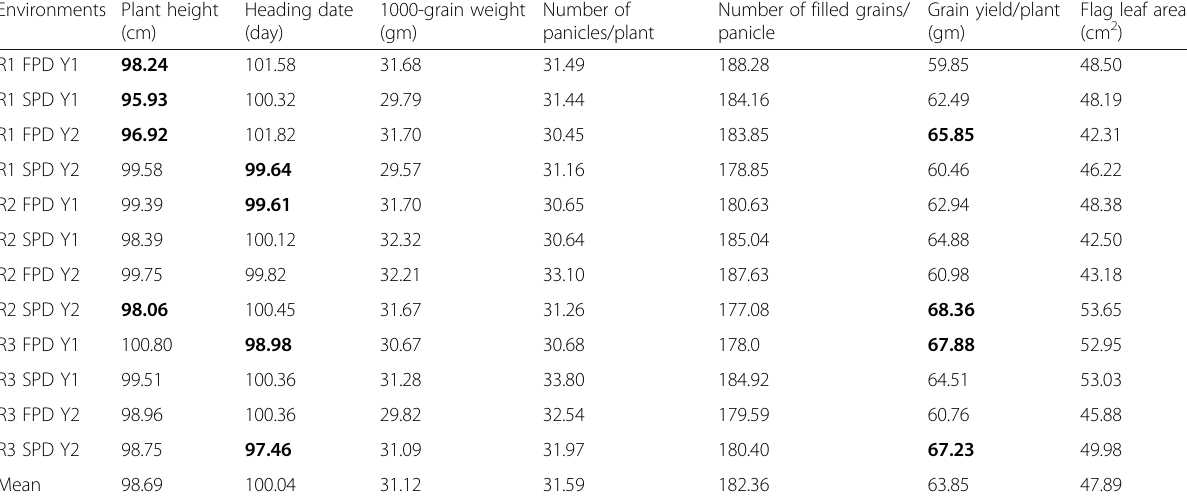
Table 12 The mean performances for all studied traits of the seven rice entries under all environments Environments Plant height